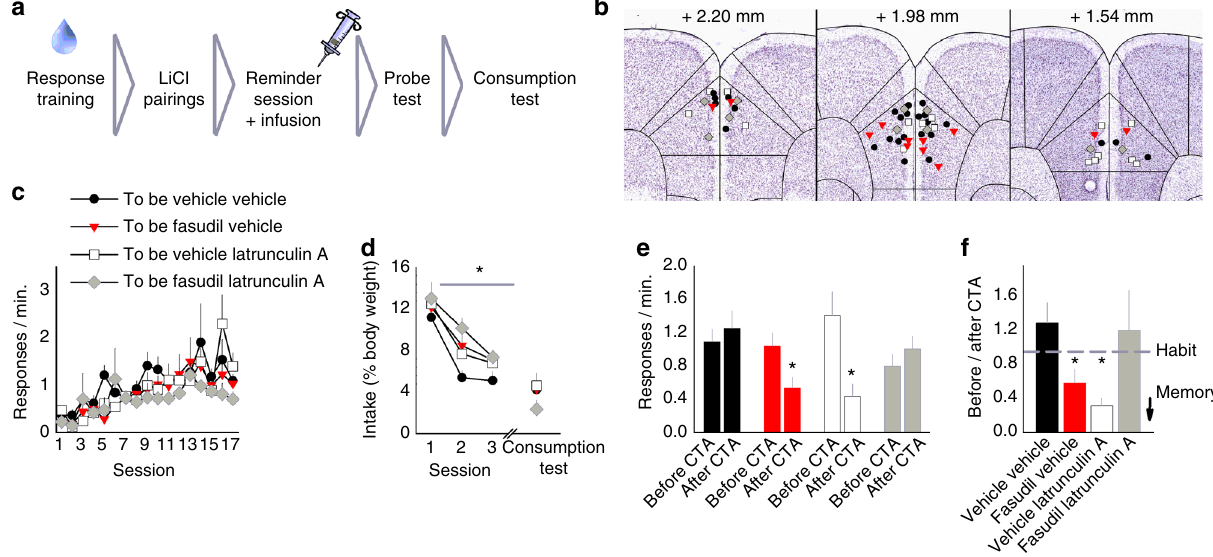
Fig. 6 Blocking F-actin polymerization in the prelimbic cortex prevents ROCK inhibition from promoting goal-directed action selection. a Experimental timeline: As in Fig. 5, mice were extensively trained to respond for an orally ingested cocaine – sucrose solution, followed by LiCl-mediated CTA and a brief “ reminder session ” paired with vehicle or fasudil. Thirty min after this injection, vehicle or latrunculin A was infused into the prelimbic cortex. Probe and post-probe consumption tests followed. b Prelimbic cortical infusion sites are indicated on images adapted from the Allen Brain Atlas. c All mice acquired the cocaine-reinforced response, with no group differences. d CTA reduced cocaine – sucrose consumption. e During the probe test, however, vehicle – vehicle-treated mice did not reduce responding relative to the last day of training ( “ before CTA ” ), indicating habitual response strategies. As expected, fasudil – vehicle-treated mice reduced responding, showing sensitivity to the now-reduced value of the reinforcer. This effect was blocked by prelimbic cortical-selective latrunculin A infusion. f The same data are represented as the ratio of response rates before vs. after CTA. Scores of 1 represent no change from baseline, whereas scores < 1 represent response inhibition (*compared to vehicle – vehicle group) ( n = 13 vehicle – vehicle, 6 fasudil –